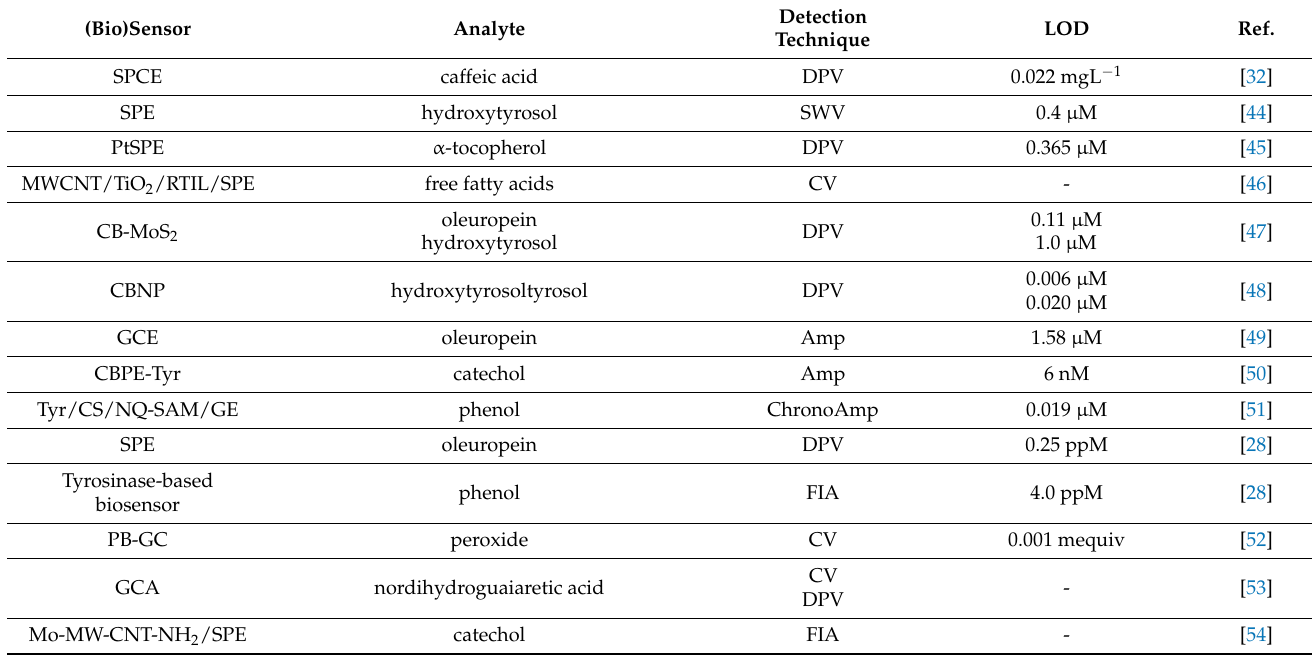
Table 1. Main electrochemical (bio)sensors, parameters analysed, electrochemical technique applied, and detection limit obtained in olive oil analysis.